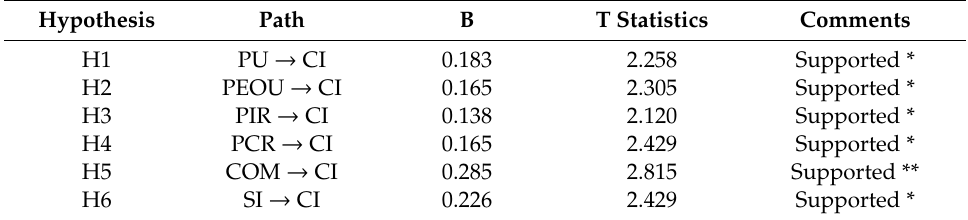
Table 4. Structural model (Source: Authors’ research).